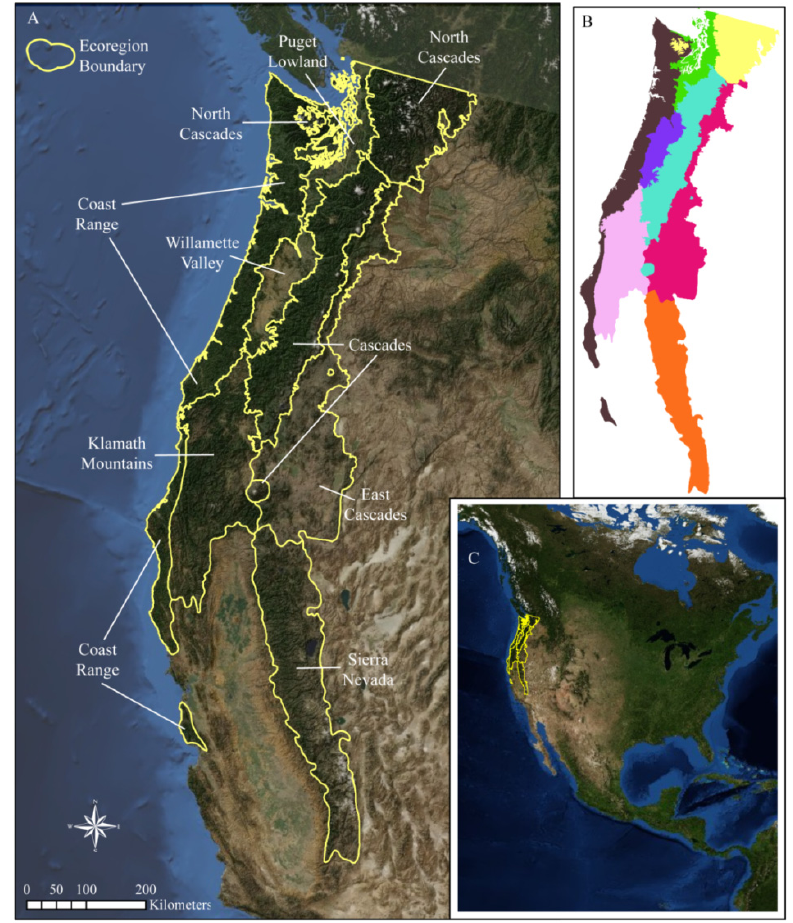
Figure 2. ( A ) The Pacific Northwest and the Level III ecoregion boundaries. Basemap satellite data copyright © ESRI, DeLorme, NAVTEQ, TomTom; ( B ) Inset map of the Level III ecoregion extent; ( C ) Location map with ecoregions in